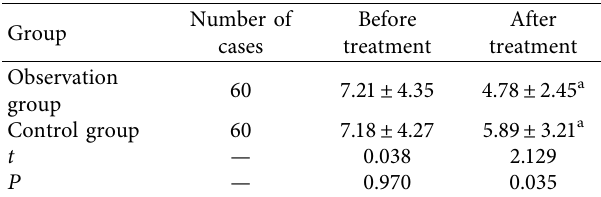
Table 5: Comparison of NIHSS scores between the two